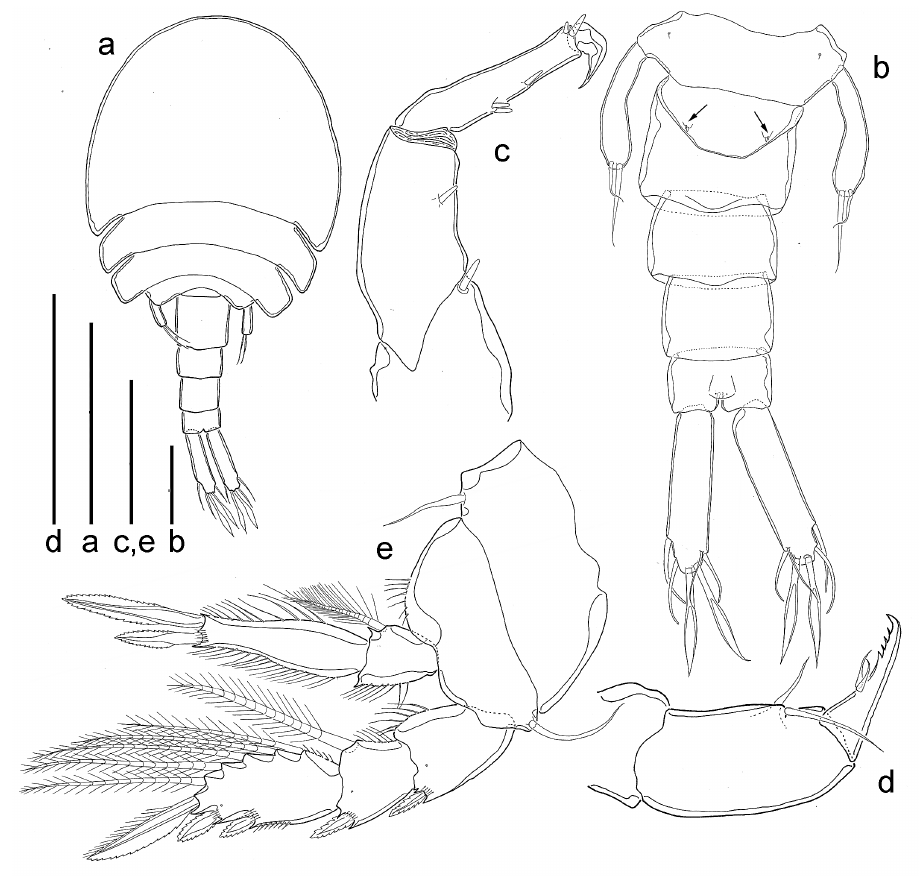
Figure 5. Spaniomolgus dentatus sp. n., female. a Habitus dorsal b Urosome dorsal (Leg 6 arrowed) c Antenna d Maxilliped e Leg 4. Scale bars: 300 μm ( a ); 100 μm ( b ); 50 μm ( c–e